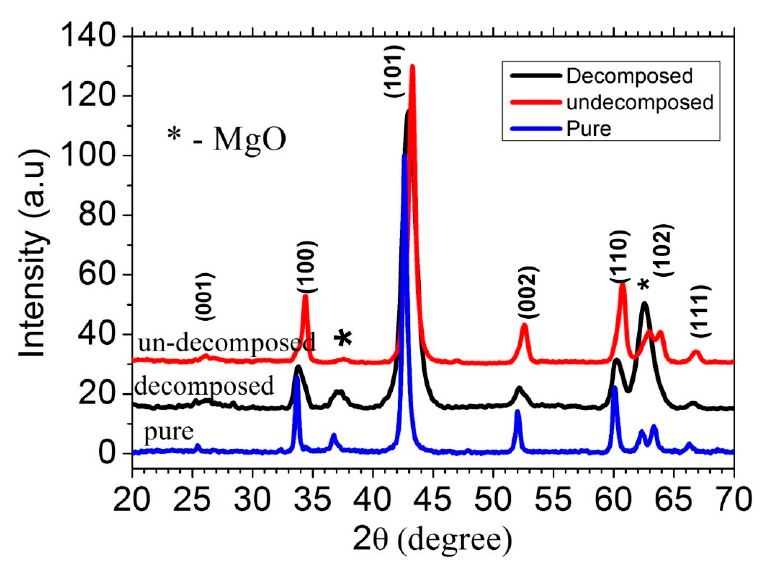
Figure 5. XRD spectra of the CNTs ‐ MgB 2 composite.